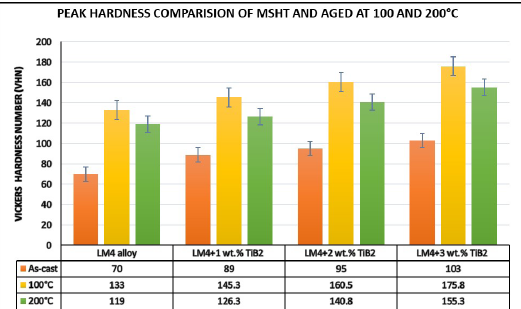
Figure 7. Peak hardness values of LM4 alloy and LM4 + TiB composites in as-cast and different aging conditions during